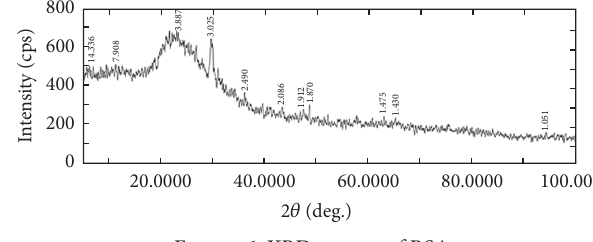
Figure 6: XRD pattern of RSA.